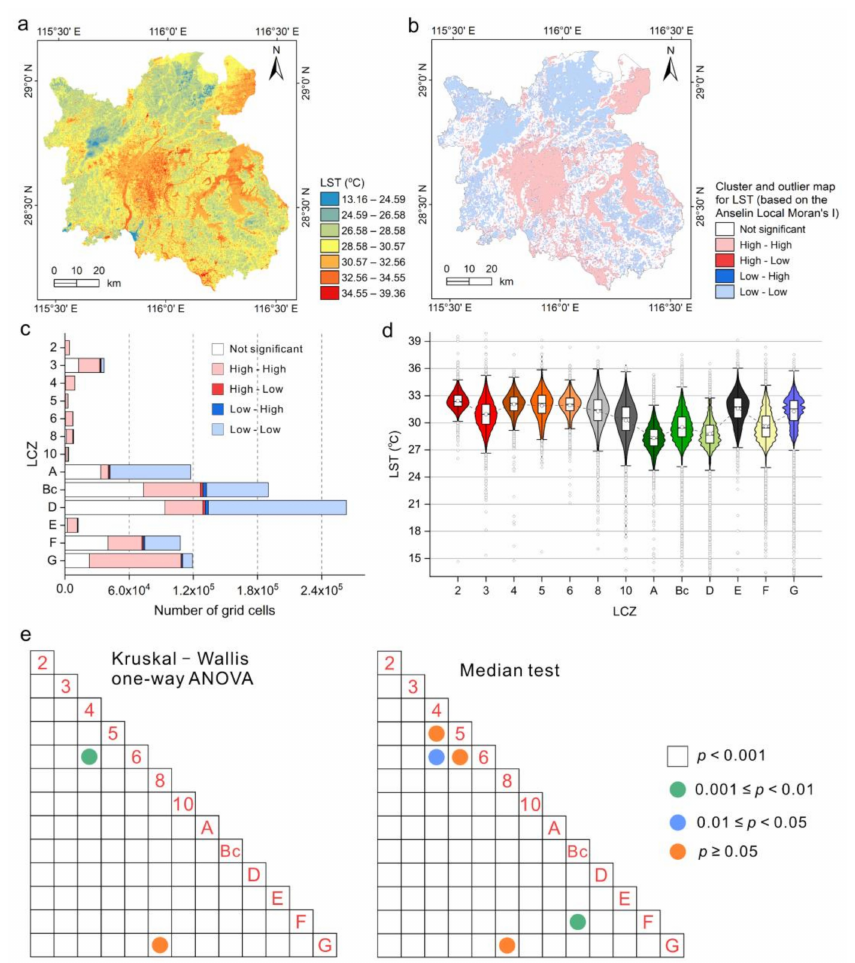
Figure 11. ( a ) Spatial distribution of nighttime LSTs in Nanchang. ( b ) Cluster and outlier map for nighttime LST. ( c ) Number of grid cells for each cluster/outlier type. ( d ) Nighttime LSTs for each LCZ class. The violin density plot displays the probability density of the LST data, with a boxplot of the mean (hollow circle), median (center horizontal line), interquartile range (black rectangle), and upper and lower whiskers (vertical lines between upper and lower horizontal lines). ( e ) Pairwise multiple comparison results of the Kruskal–Wallis one-way ANOVA test and median test, respectively. Blank cells indicate pairs of LCZs with significantly different LSTs ( p <